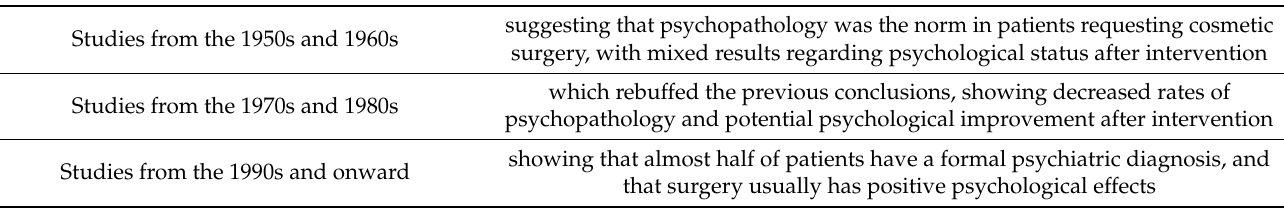
Table 1. The three main stages of scientific literature regarding the psychological disorders associated with cosmetic surgery